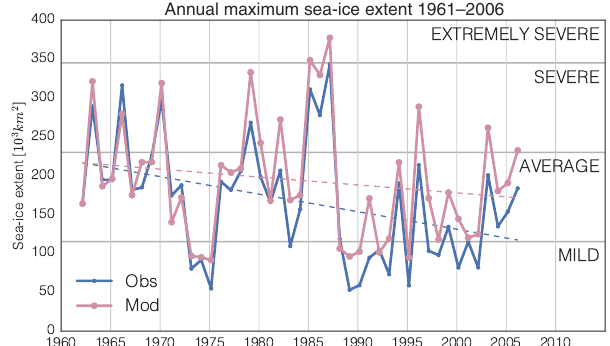
Figure 8. Simulated (red solid line) and observed (blue solid line) annual maximum daily sea-ice extents in the Baltic Sea, for the pe- riod 1961/1962–2005/2006. The horizontal grey lines show the lim- its for winters with a maximum sea-ice extent in the Baltic Sea clas- sified as mild, average, severe, and extremely severe, respectively. The dashed red and blue lines show the linear trends for simulated and observed maximum sea-ice extents,